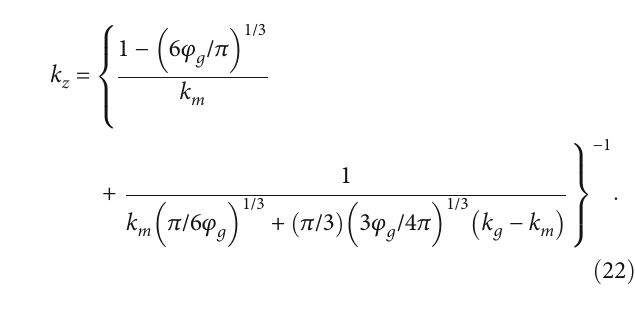
Figure 6: Cubic pore model.